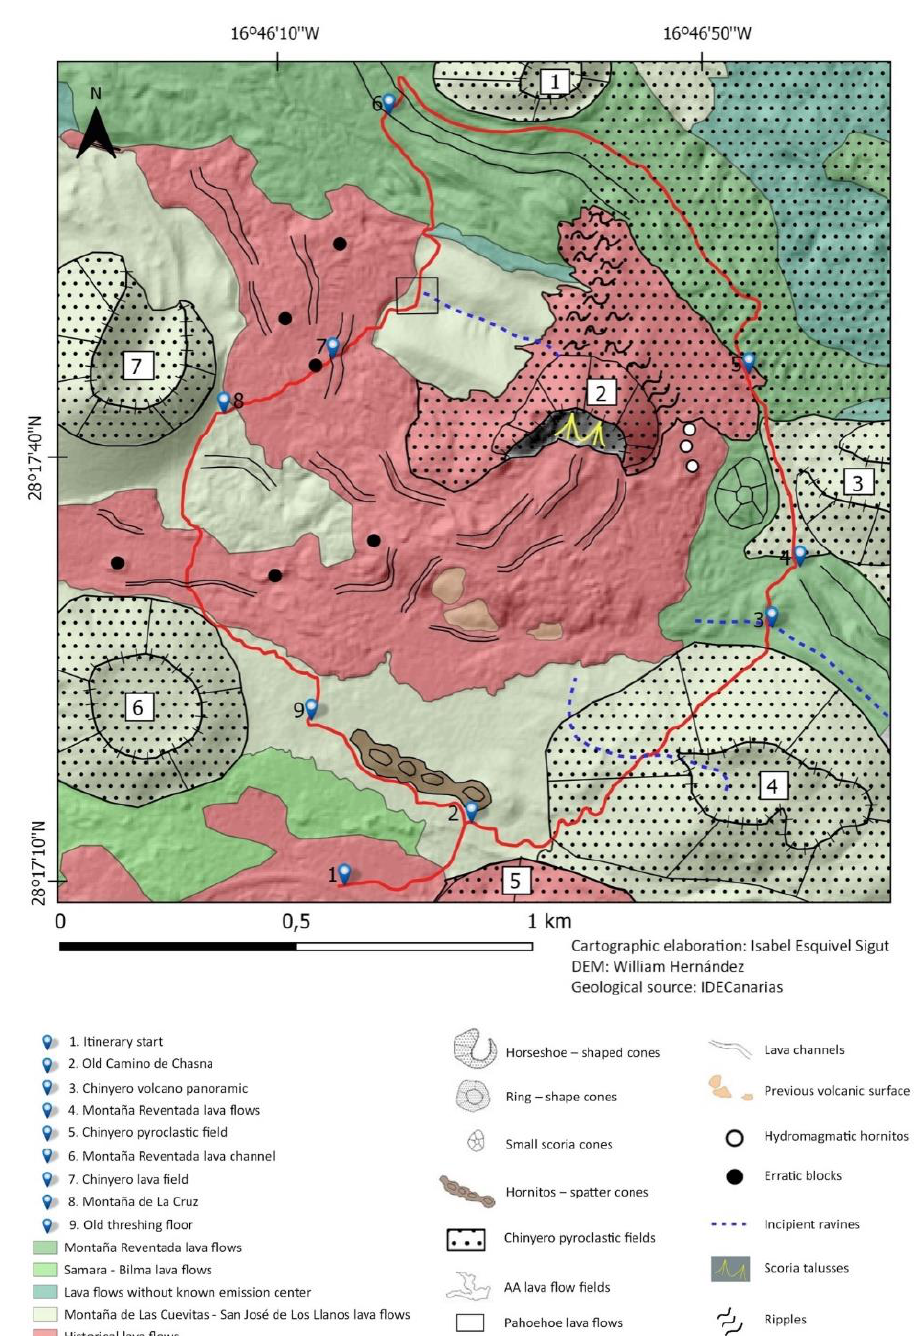
Figure 5. Geomorphological map of the eruptive centres of Chinyero. 1. Las Flores 1470 masl. 2. Chinyero 1550 masl. 3. Chica de Abeque 1581 masl. 4. Corredera 1622 masl. 5. Boca Cangrejo 1588 masl. 6. Los Poleos 1471 masl. 7. La Cruz 1520 masl. Source: IDE-Canarias, self-elaboration.